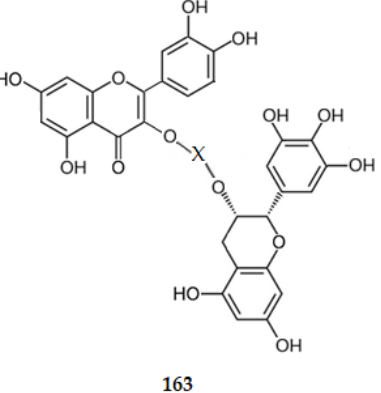
Figure 19. Structure of a model of MTDL.